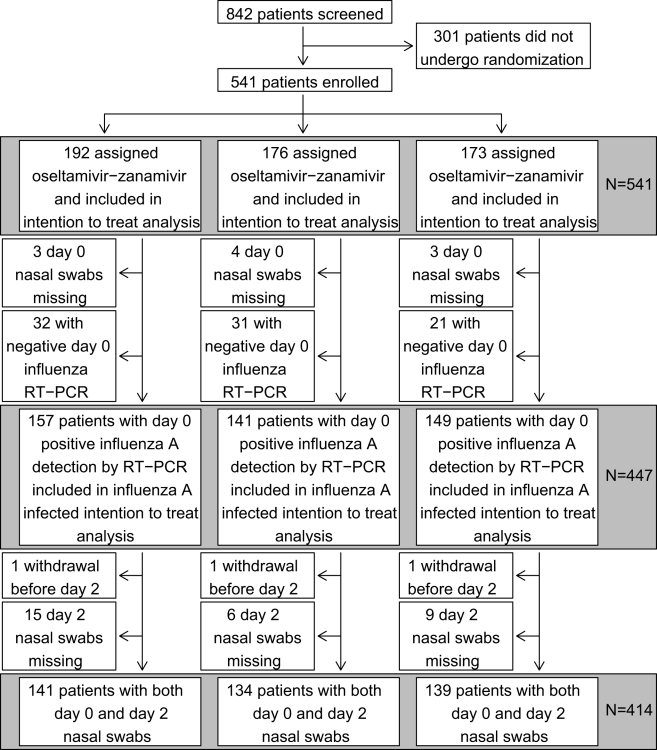
Trial flow chart.